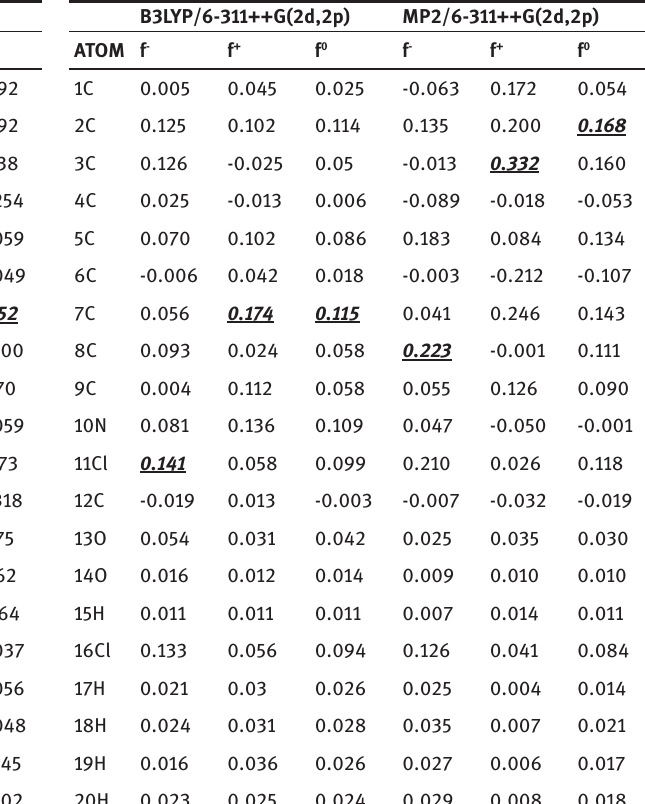
Table 4: Values of the condensed Fukui function in quinclorac computed from NBO charges according to Eqs. 9, 11, 12 in aqueous